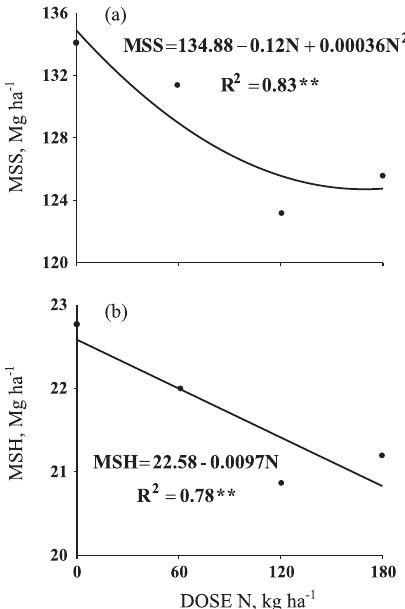
Figure 6. Stalk yield (a) and sucrose production (b) in terms of the residual effect of the doses of N- NH Cl (third ratoon of sugarcane). ** significant 4 at 5